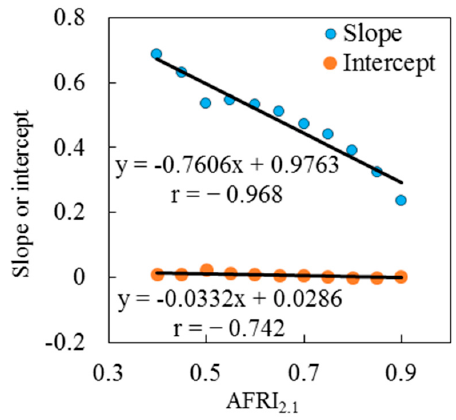
Figure 4. The slopes and intercepts of regression functions (for each graph in Figure 3) as a function of AFRI 2.1 .